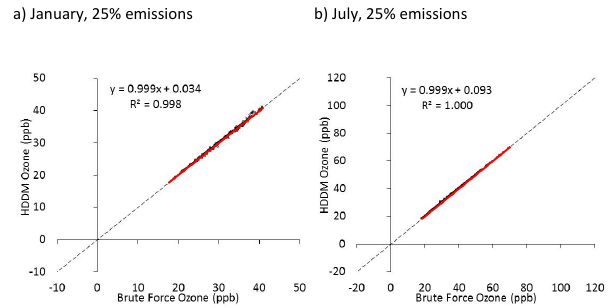
Fig. 10. Same as Fig. 9 but for the rural Weatherford